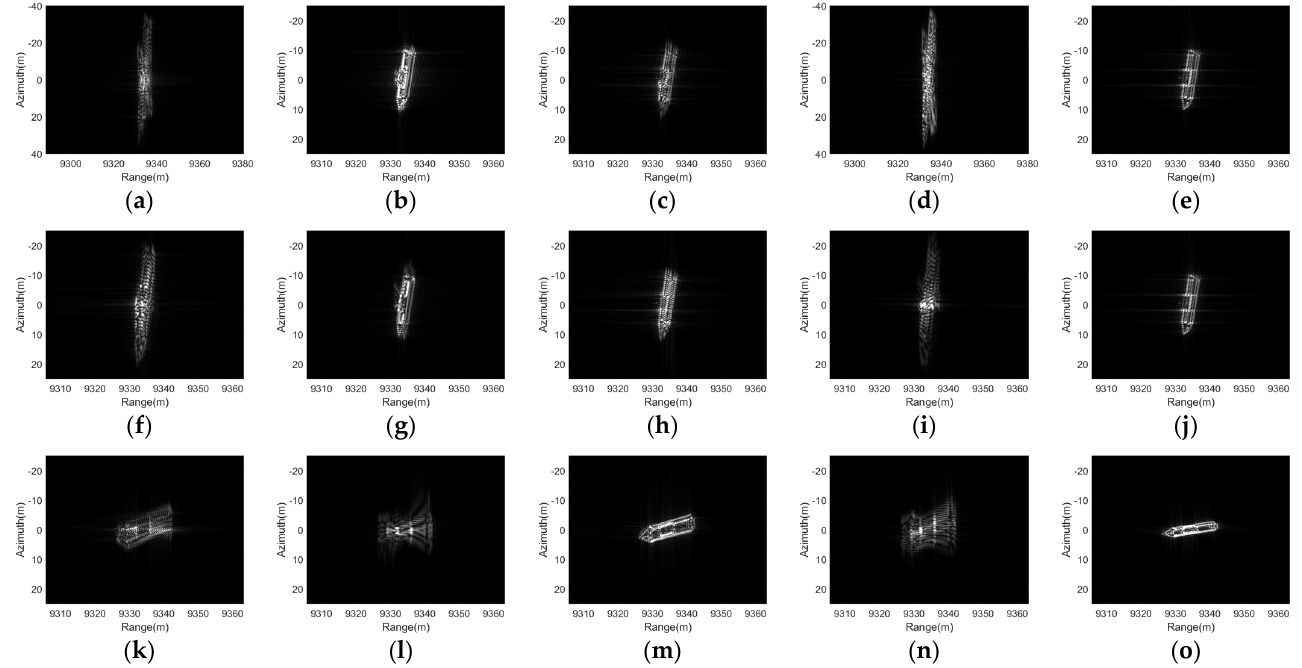
Figure 23. The focusing results of the oscillatory ship in the different states. ( a – e ) In the unanchored state; ( f – j ) in the anchored state; ( k – o ) in the navigating state. The motion types from left to right are roll, pitch, yaw, all the three angular oscillations, and stationary.